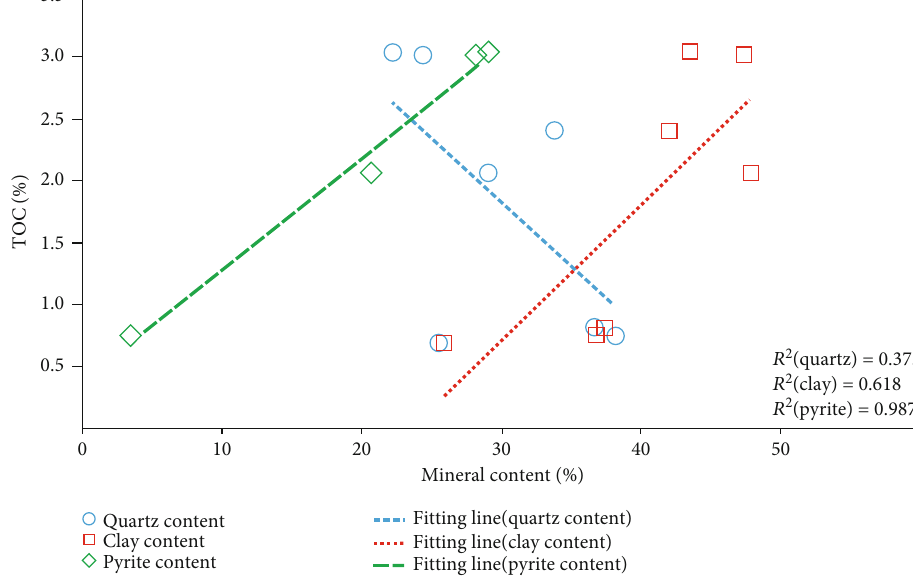
Figure 10: Correlation between organic abundance and mineral content of Longtan shales.